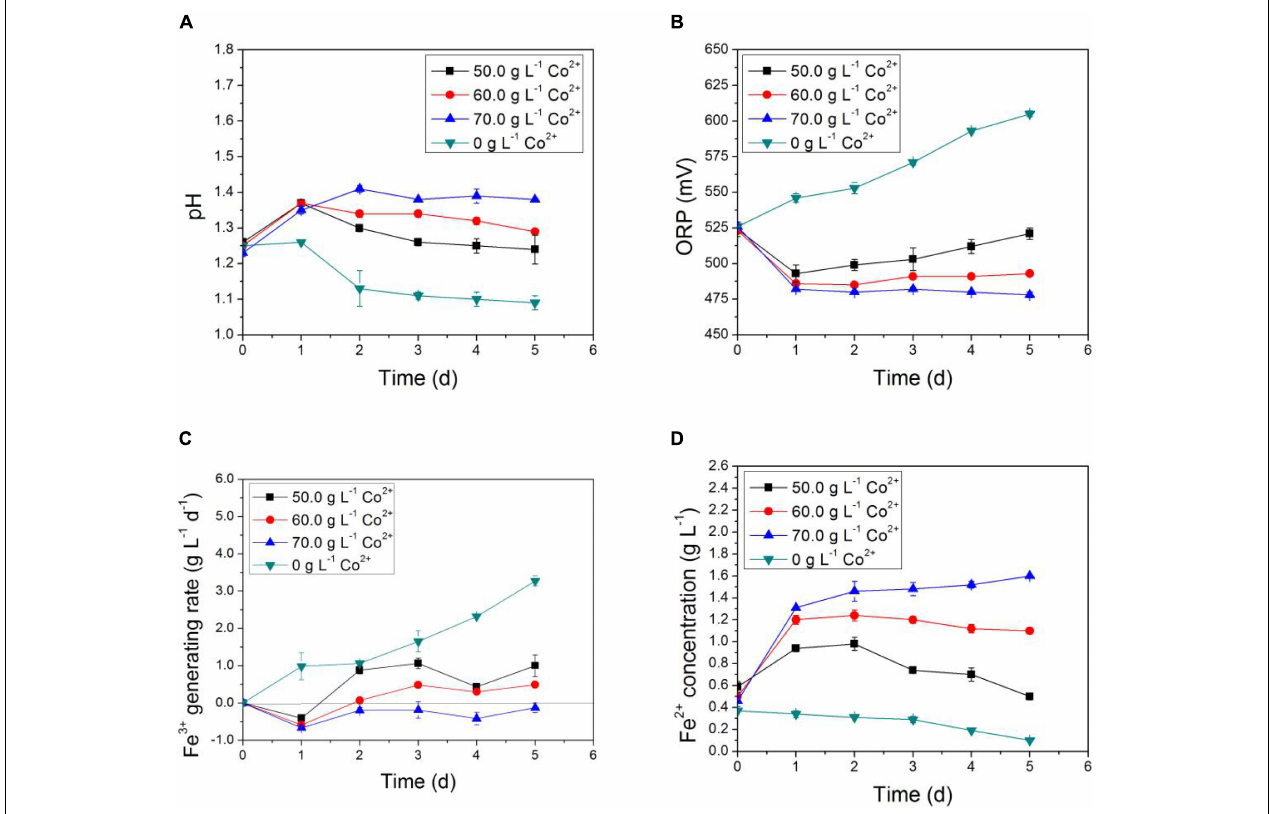
FIGURE 4 | Time-courses for (A) pH, (B) ORP, (C) Fe 3 + generation rate, and (D) Fe 2 + concentration in simulated bioleaching system of different Co 2 +